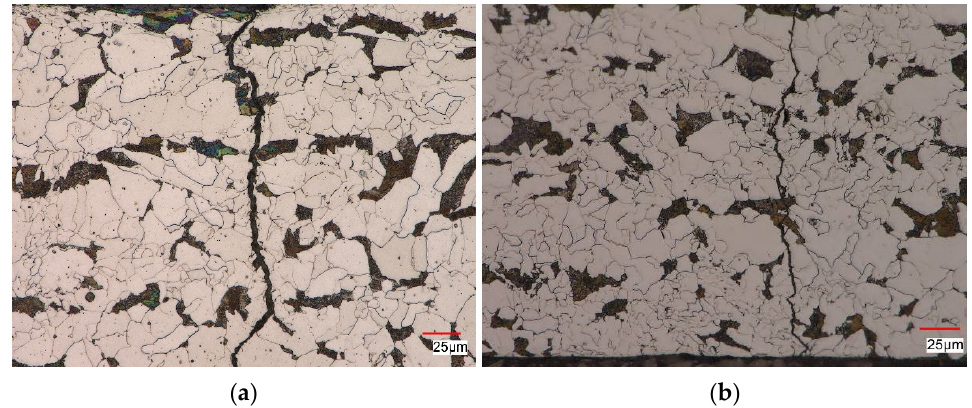
Figure 19. Structure of S420M steel after fatigue test at ε ac = 1.0%: ( a ) non-pre-deformed sample, ( b ) pre-deformed sample (10%).